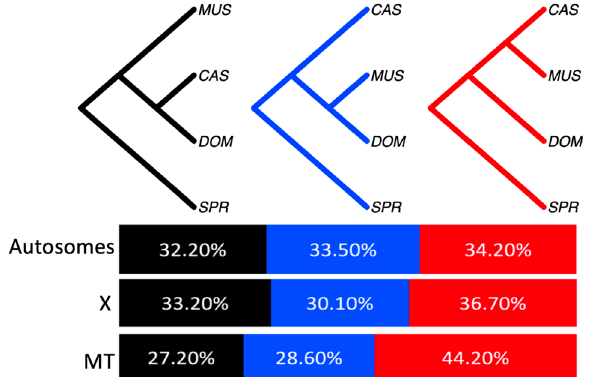
Figure 4. The percentage of the autosomal, X, and mitochondrial (MT) genome supporting each of the three possible topological relationships relating the three primary house mouse subspecies. Percentages correspond to the representation of each topology across 13,122 genomic regions. M. m. castaneus (CAS), M. m. musculus (MUS), M. m. domesticus (DOM), and outgroup M. spretus